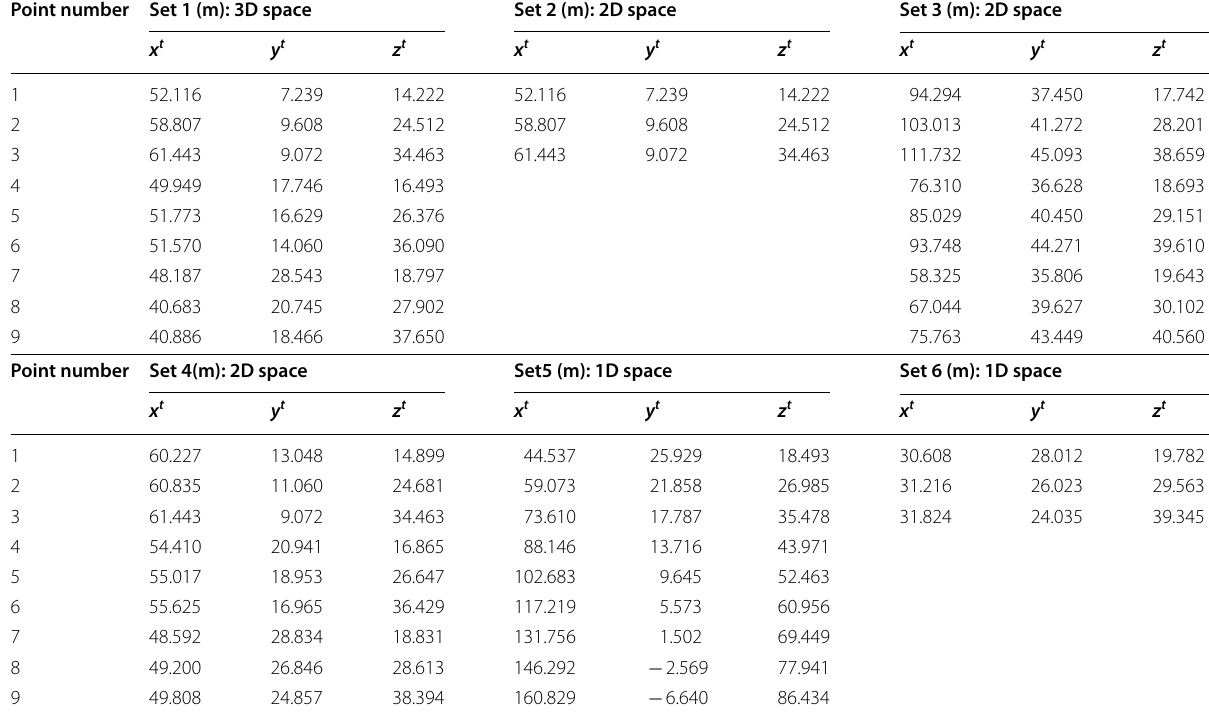
Table 11 Simulative true coordinates of control points in the target system Point number Set 1 (m): 3D space Set 2 (m): 2D space